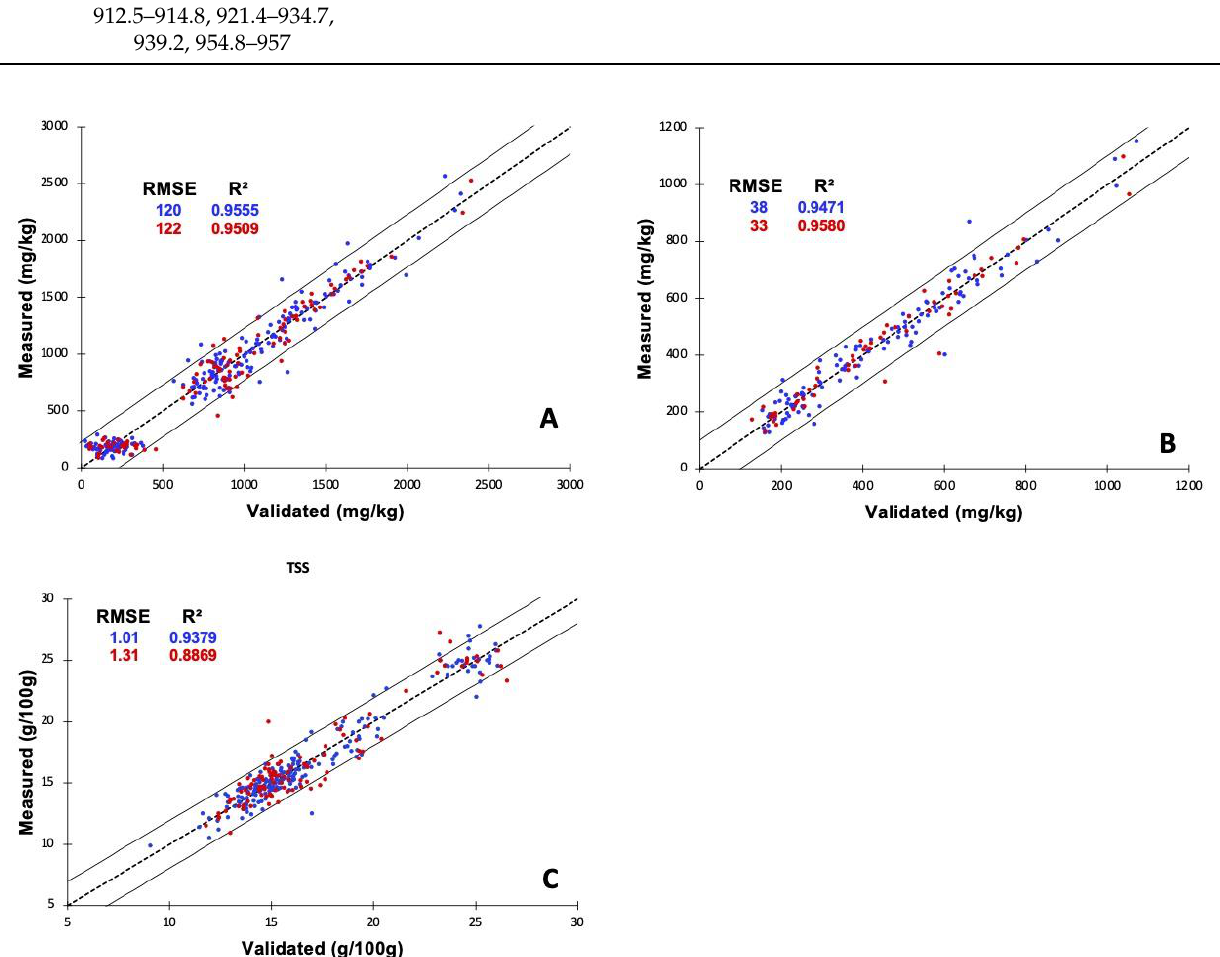
Figure 8. Performance of PLS model using the optimal wavelength windows extracted from VIPs score (>1) of PLS analysis. Calibration and external validation for ( A ) Total Flavonoids, ( B ) Total Anthocyanins, and ( C ) Total Soluble Solids. Blue dots indicate calibration set and red dots represent validation set.